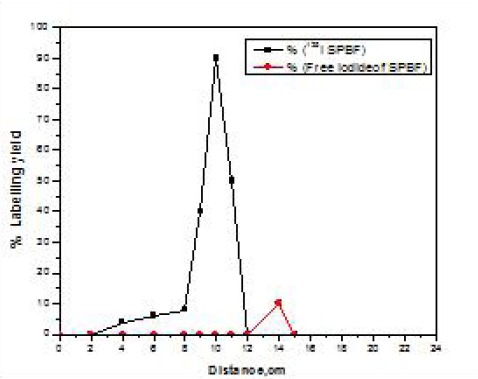
Electrophoresis radiochromatogram of 125I-ASPMBF